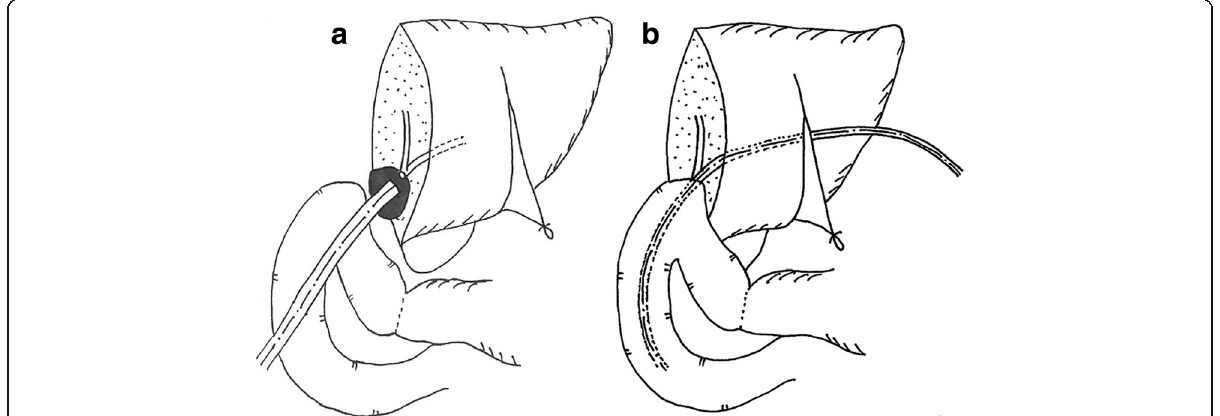
Fig. 1 Schema of anatomical relationship between the biliary duct and duodenum a before magnetic anastomosis and b after anastomosis. a External drainage tube was placed in the biliary cavity and b PTBD tube was placed over the